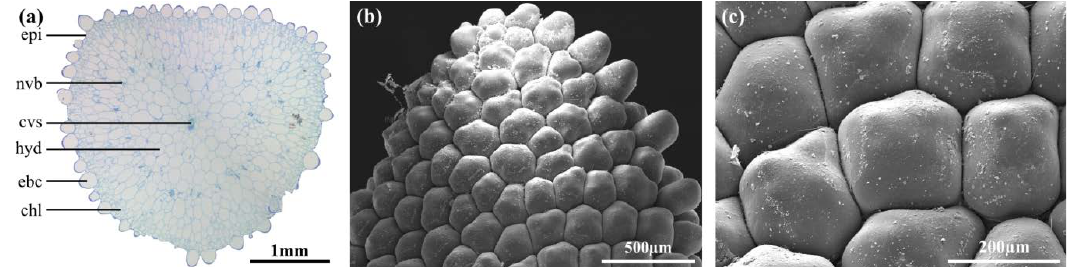
Figure 9. Delosperma harazianum. ( a ) Light microscopic image of a transverse section of an almost circular leaf stained with toluidine blue. ( b , c) Scanning electron microscope images of a leaf tip ( b ) and epidermal bladder cells ( c ). chl: chlorenchyma; cvs: central vascular strand; ebc: epidermal bladder cell; epi: epidermis; hyd: hydrenchyma; nvb: peripheral net of vascular bundles.